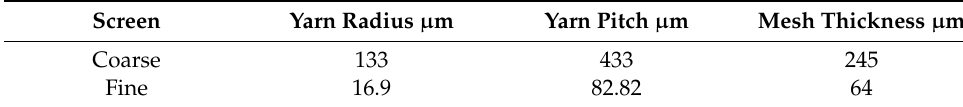
Table 1. Geometric properties of the wire mesh